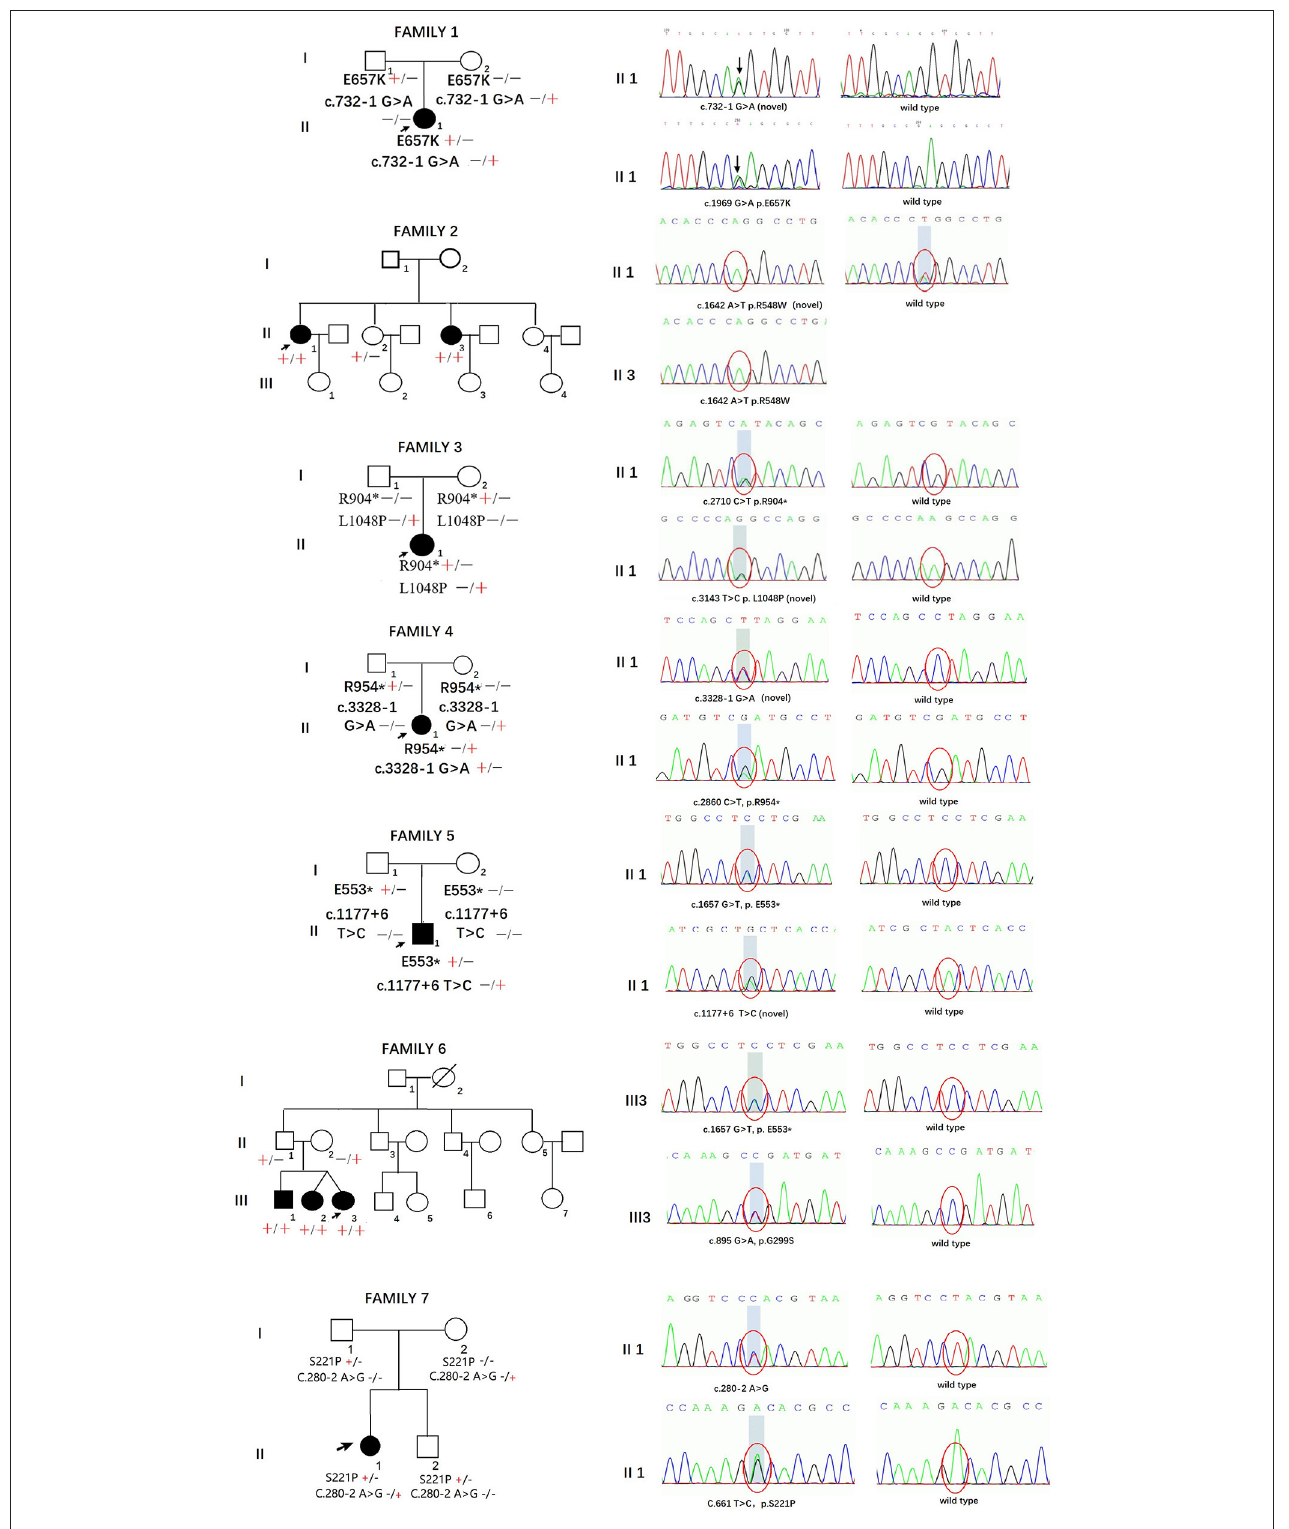
FIGURE 1 | Pedigrees and genotypes of seven families in our study with novel SH3TC2 variants.